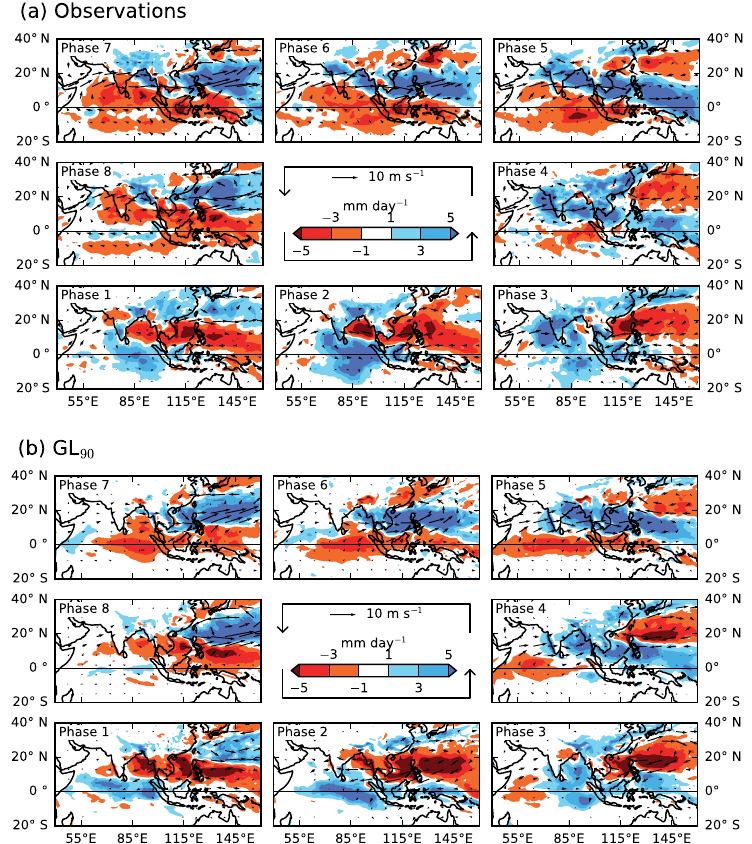
Figure 10. MJJASO anomalies in each BSISO1 phase of precipitation (shading) and 850hPa wind (vectors; anomalies with amplitude greater than 0.5ms − 1 only) for (a) observations, (b) GL 90 . Phase 1 is in the bottom left corner and phases continue anticlockwise round the diagram.